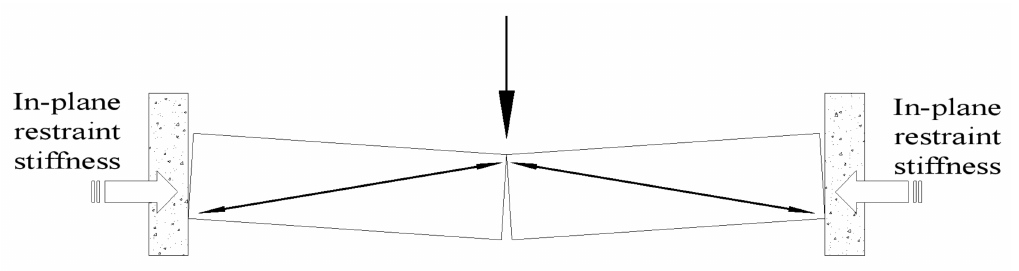
Figure 1. Compressive membrane action